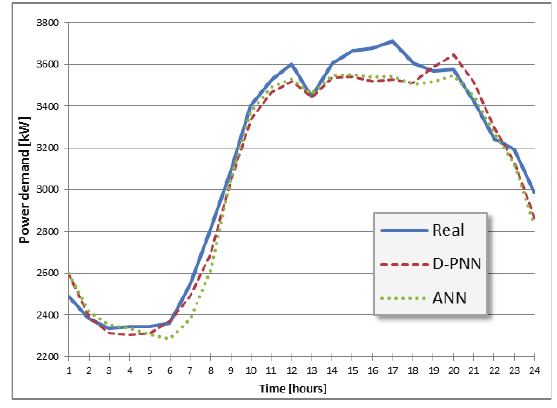
Fig. 8. TEPCO : 2.7.2012 (Monday). D-PNN RMSE = 85.7 , ANN RMSE = 92.2